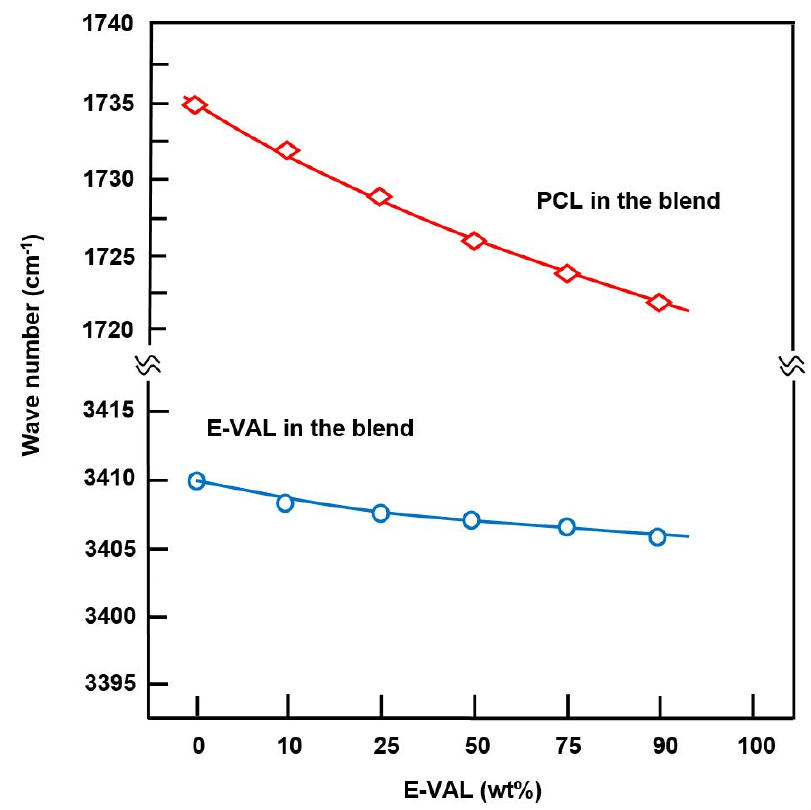
Figure 2. Shift variation in the absorption bands of the hydroxyl groups of E-VAL and the carbonyl groups of PCL in E-VAL/PCL blends versus E-VAL content.